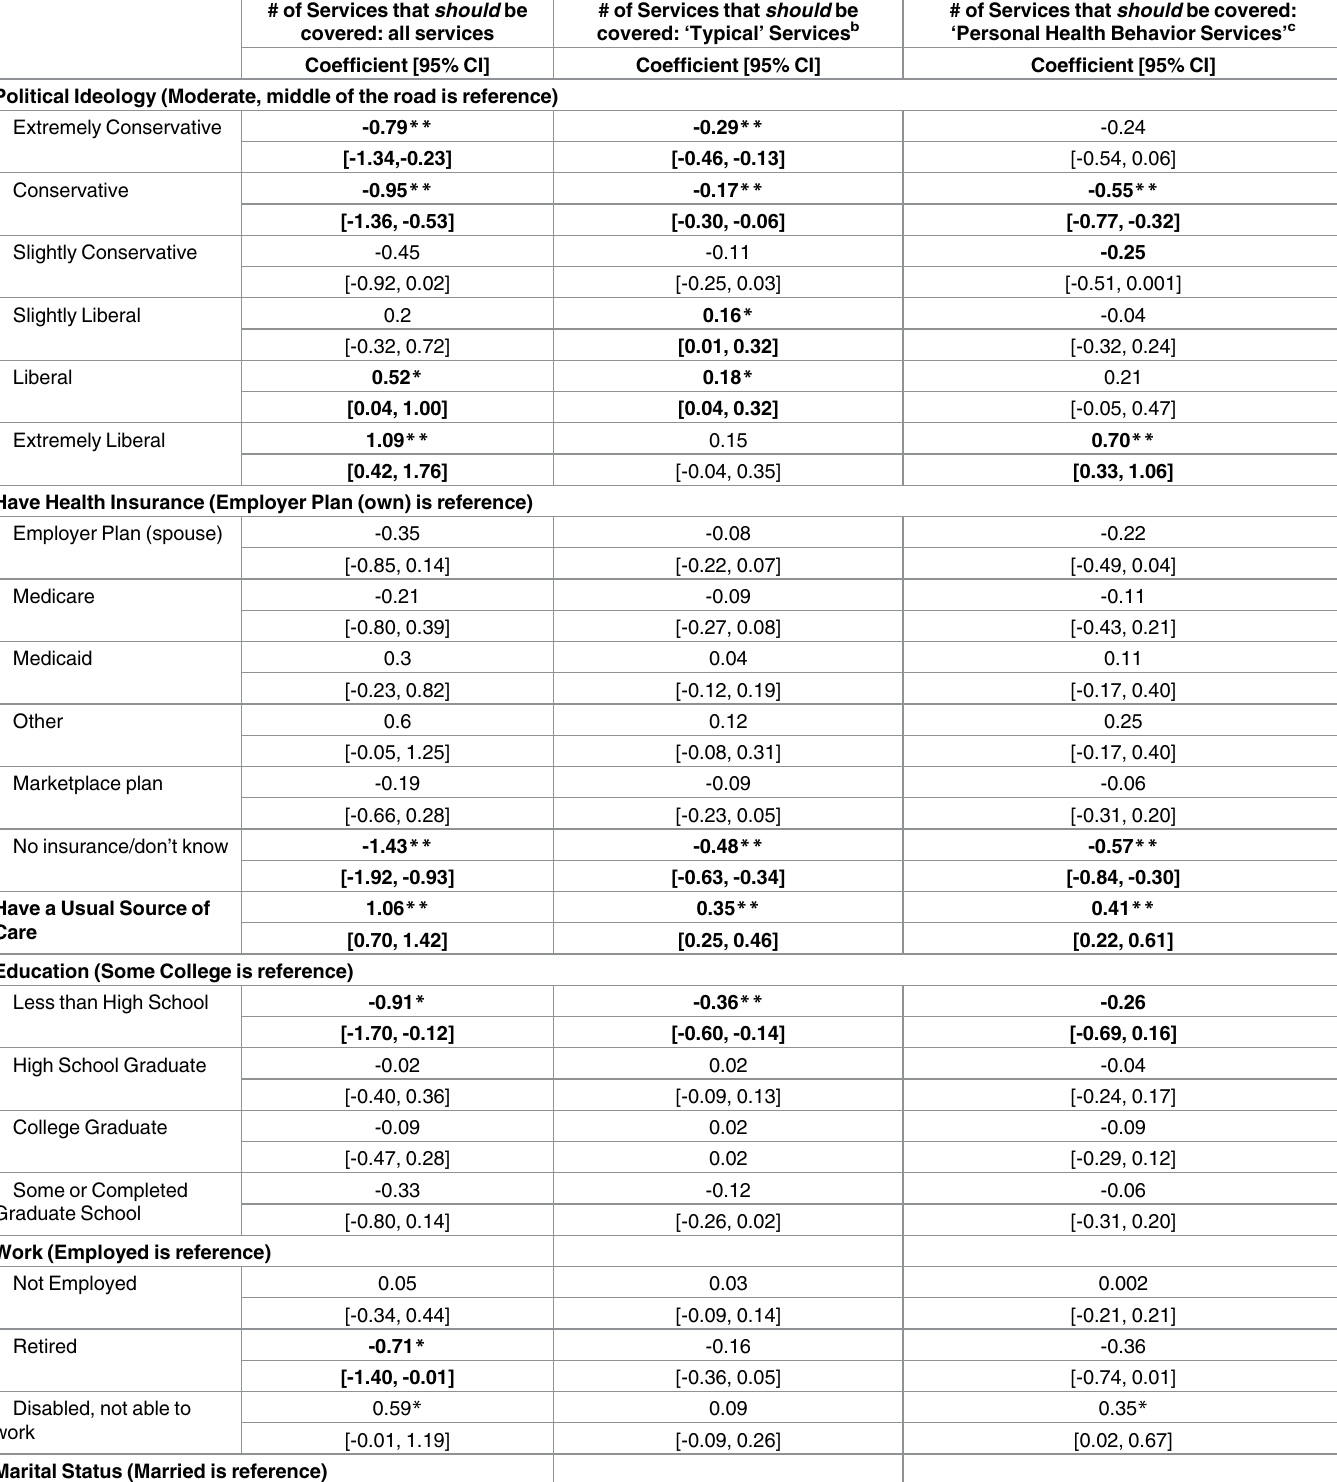
Table 4. Coefficients and 95% CIs for the Linear regression of the number of servicesthat should be covered, typical services,and personal health behavior services. (N = 2989 a ). # of Services that should be # of Services that should be covered: all services covered: ‘Typical’ Services